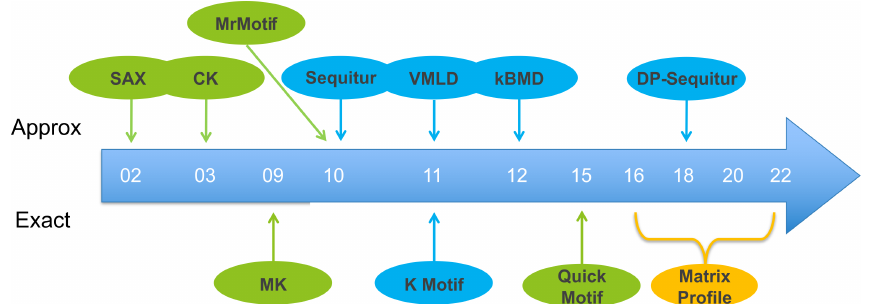
Figure 1. Motif discovery algorithm highlights timeline. Green indicates fixed-length algorithms while blue represents variable length